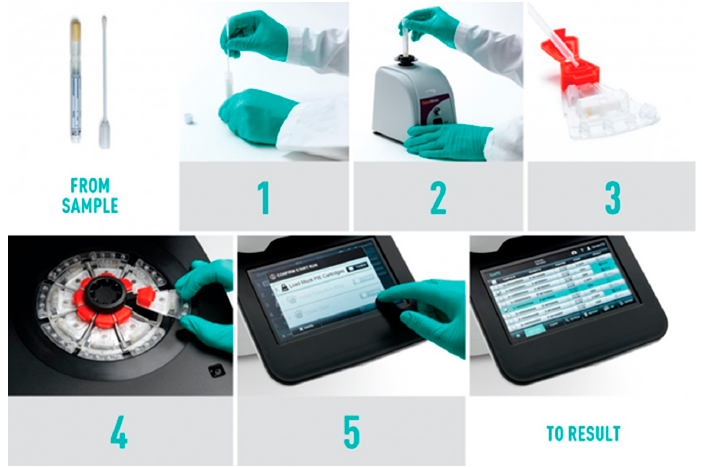
Figure 2. The workflow of the GenePOC platform. Source: GenePOC Inc.